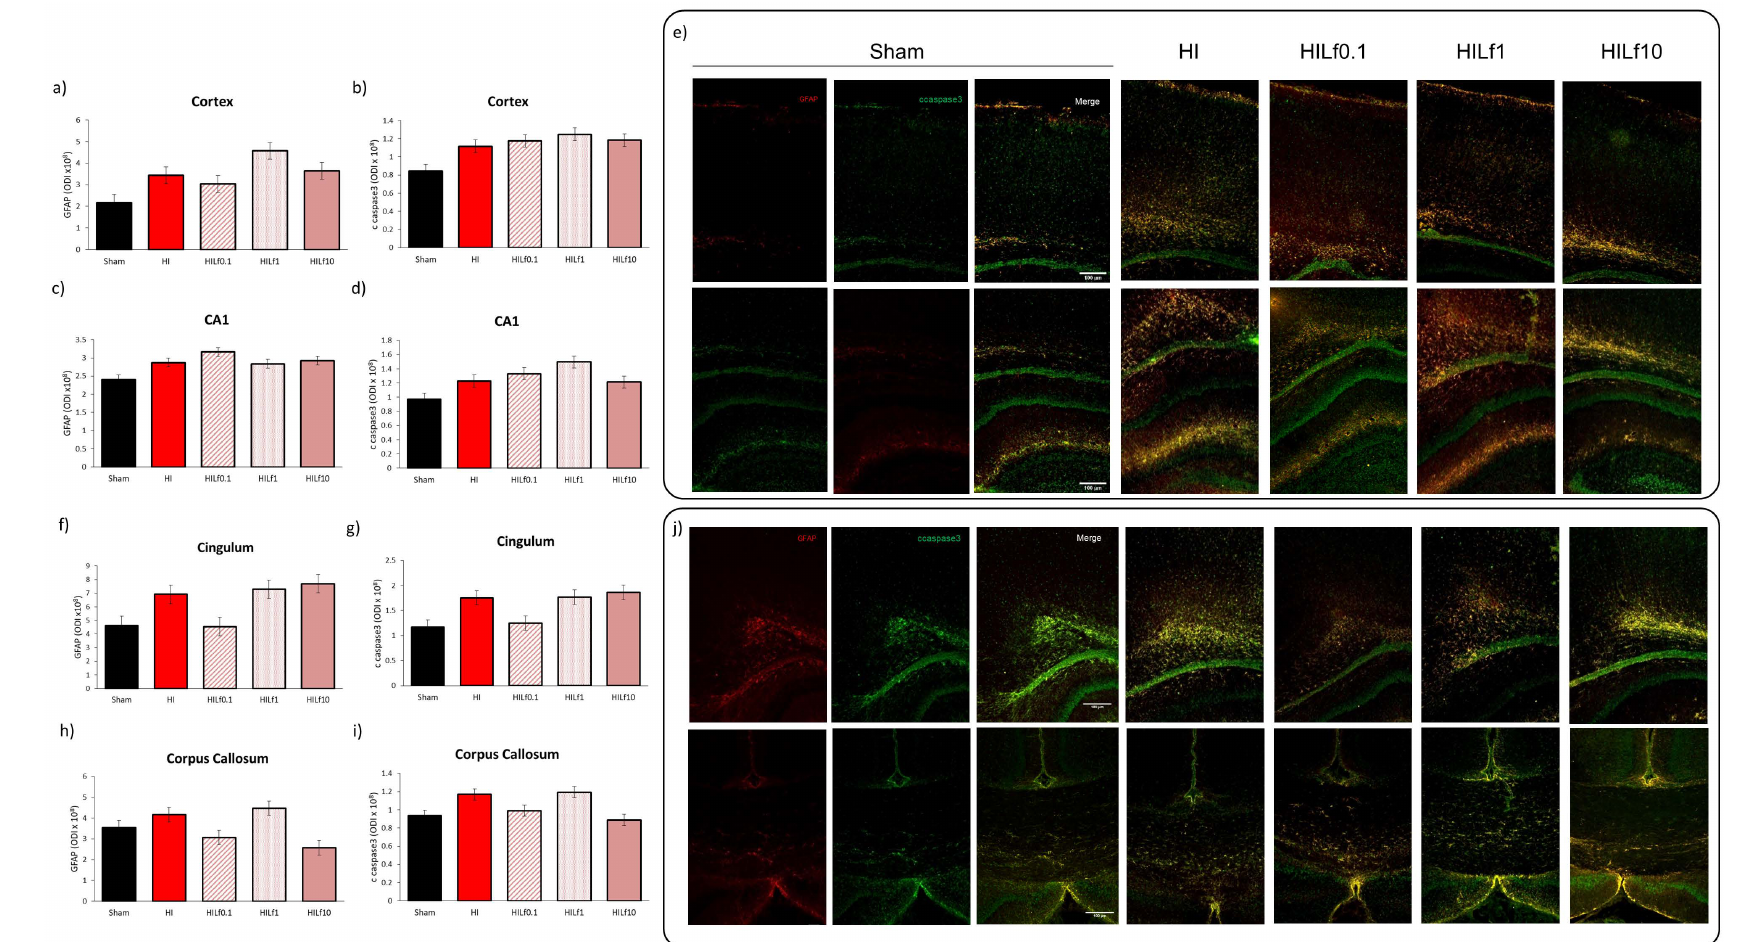
Figure 5. Optical density intensity (ODI) assessment of astrocytes (GFAP) and cleaved caspase 3 (apoptosis) in the cortex ( a and b , respectively), CA1 ( c and d , respectively), cingulum ( f and g , respectively), and corpus callosum ( h and i , respectively) in a 200 × 200 µ m area in 30 µ m brain slices at the dorsal hippocampus level at P4. Representative images of the brain regions assessed ( e , j ). Scale bar 100 µ m. Differences were determined by one-way ANOVA and considered significant when p < 0.05 ( n = 3–5 animals/group). No significant differences were